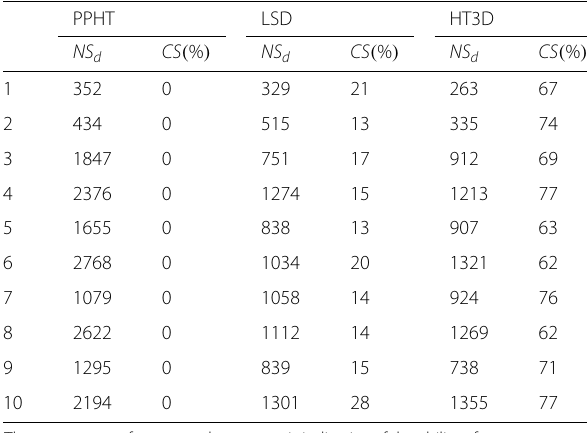
Table 3 Number of detected segments ( NS d ) and percentage of connected segments ( CS ) for the ten test